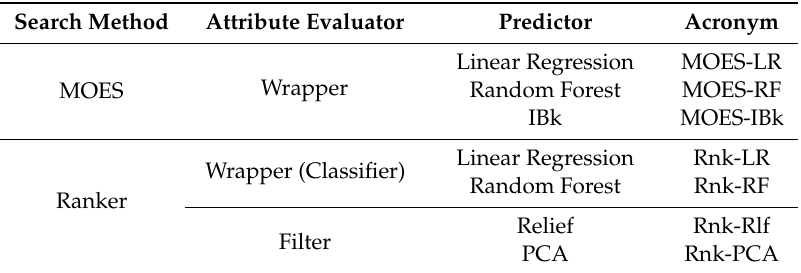
Table 2. Applied Features Selection techniques.